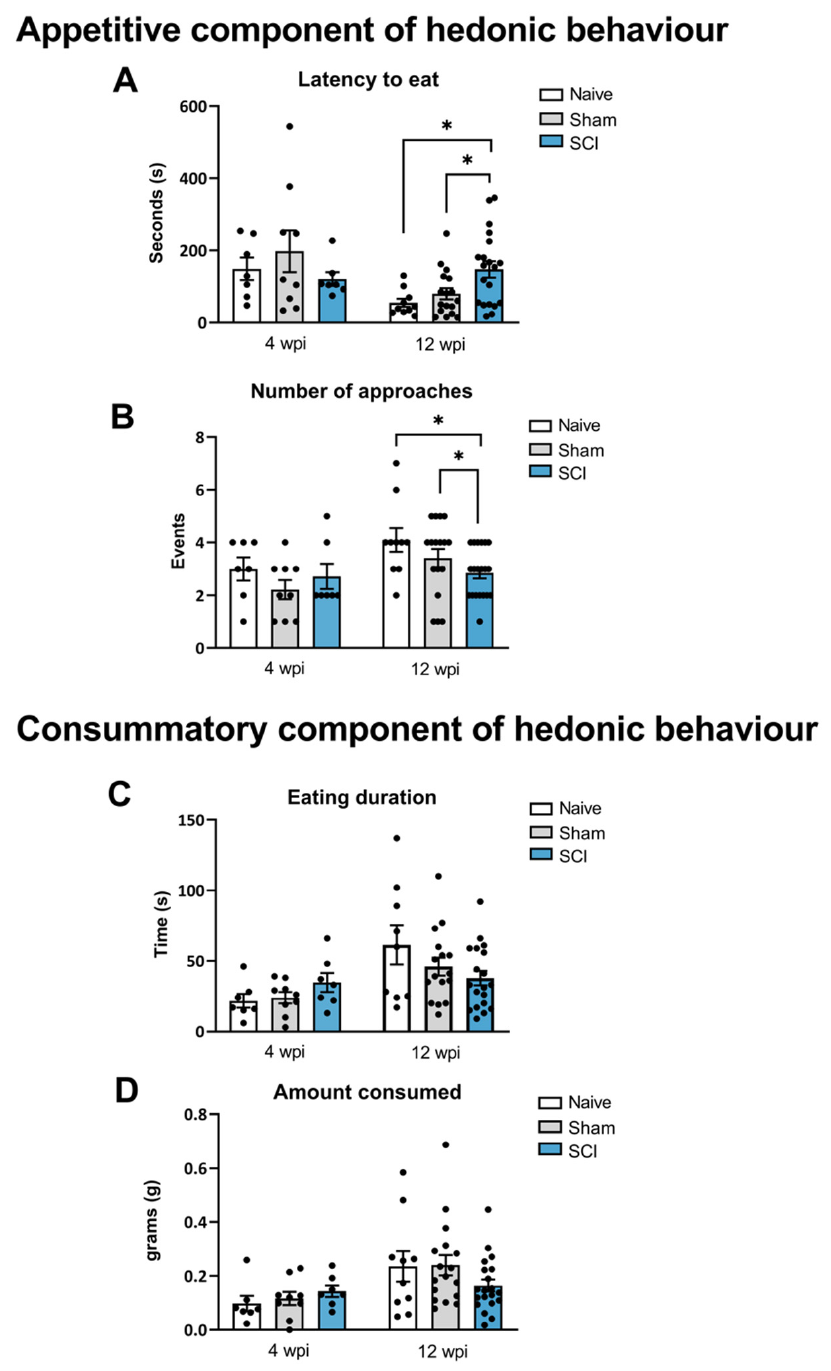
Figure 3. Reward-Seeking Behavior (RSB) test after mild spinal cord injury (SCI). Alterations in the hedonic state of the SCI-injured mice were detected at 12 wpi. Latency to eat ( A ) and approaches to eat ( B ) describe the appetitive component of the hedonic behavior whereas the eating duration ( C ) and the amount consumed ( D ) report the consummatory component of hedonic behavior in the RSB test. Results are the mean ± SEM.). * p < 0.05 (one-way ANOVA followed by Tukey’s post-hoc test). SCI, spinal cord injury; wpi, weeks post injury.